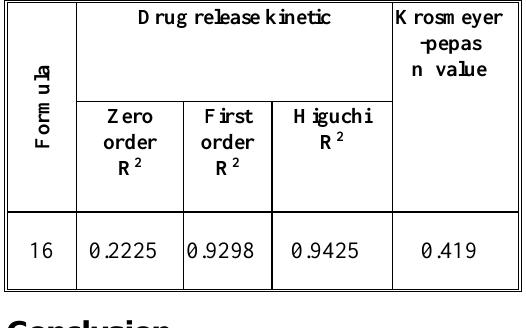
Table5.The kinetic and the mechanism of the release data of darifenacin hydrobromide from NLC Drug release kinetic a u l m r o F